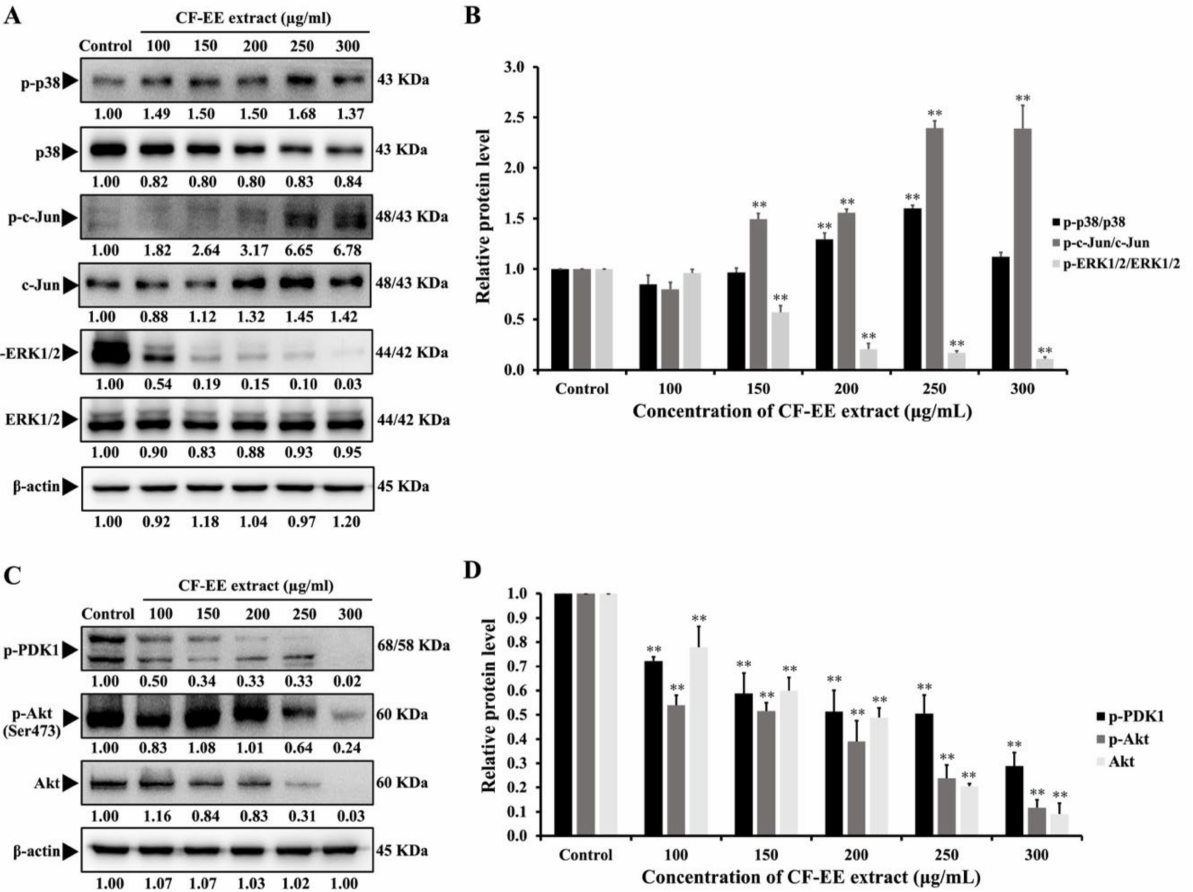
Figure 8. Effect of CF-EE extract on MAPK and Akt pathway. HeLa cells were treated with CF-EE extract at various concentrations for 24 h, and protein expression was determined by Western blot analysis. ( A ) Expression of p-p38, p38, p-c-Jun, c-Jun, p-ERK1/2, and ERK1/2. ( B ) Relative band intensity of MAPKs protein. ( C ) Expression of p-PDK1, Akt, and p-Akt(Ser473). ( D ) Relative band intensity of p-PDK1, Akt, and p-Akt(Ser473). β -actin was used as an internal control. The values are represented as the mean ± SD. ** p < 0.01 compared to the